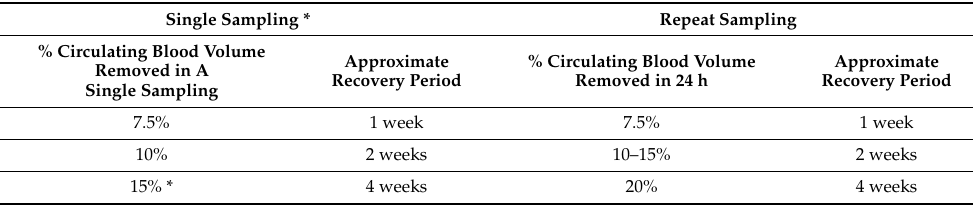
Table 1. Recommended blood volume limits and recovery periods (reprinted with permission and modified from